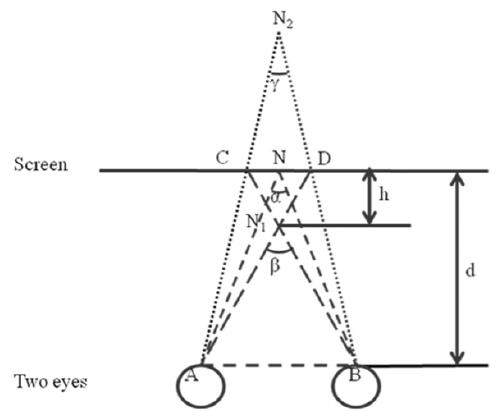
Fig. 1. Diagrammatic sketch of convergence angle and the